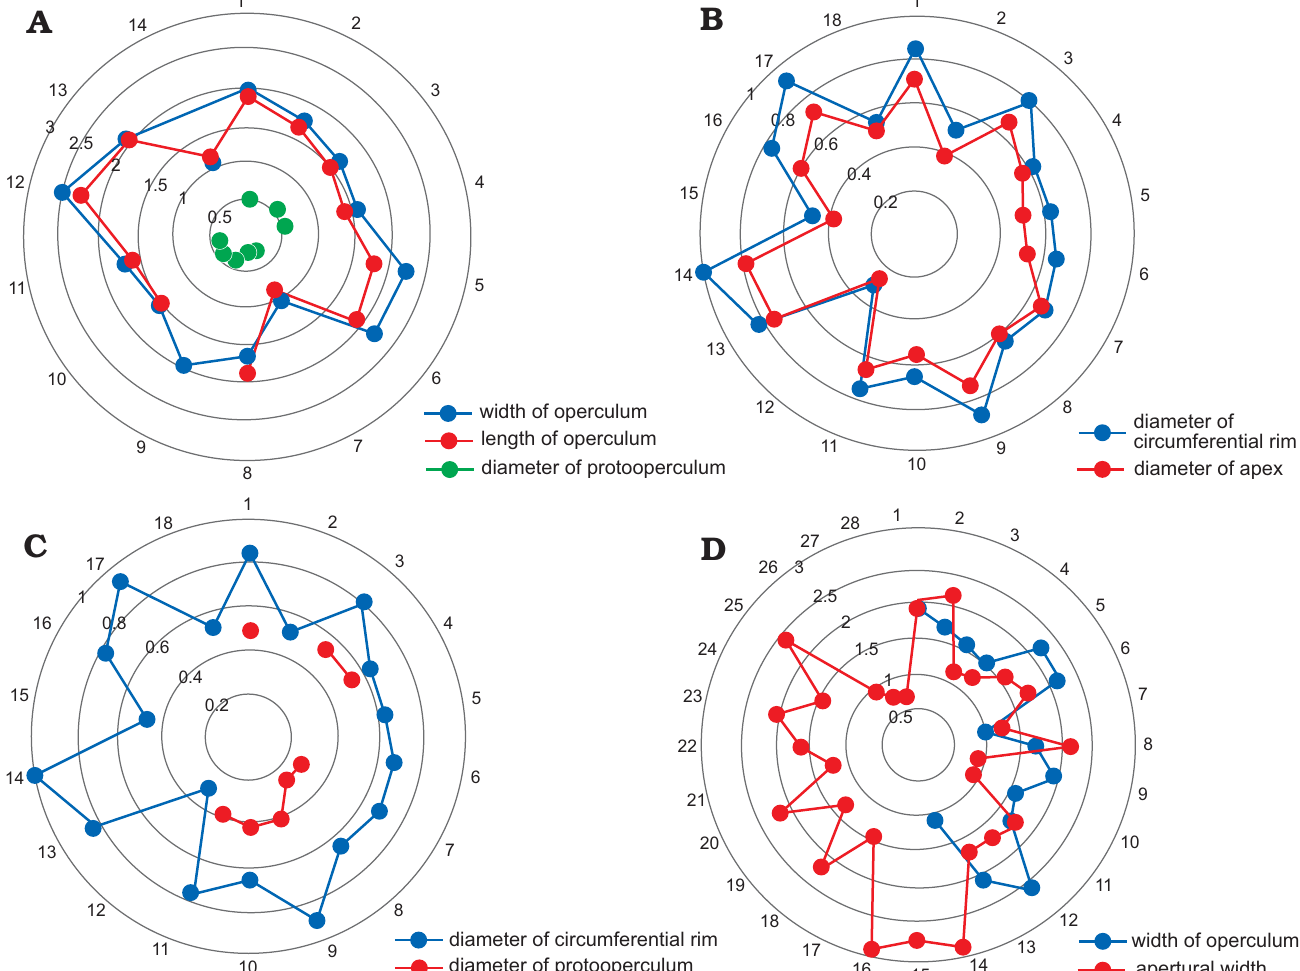
Fig. 7. Statistical distribution of different skeletal parts, junctions of the outermost ring represent the number of data, and concentric circles represent length (in